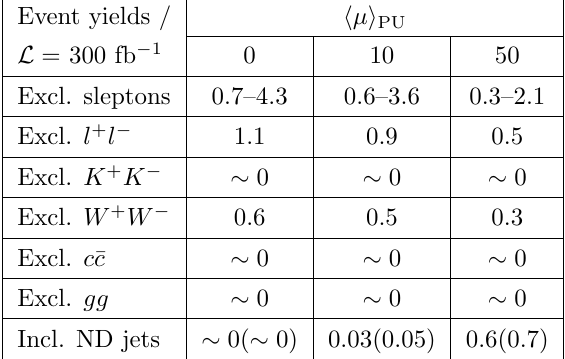
Table 9 . The same as in table 8 but for the enlarged tracker coverage j (cid:17) j < 4 : 0. latter corresponds to j (cid:17) j < 4 : 0 (i.e. the upgraded tracker coverage). To give a global picture, these results correspond to the full di-lepton mass range of 2 < m